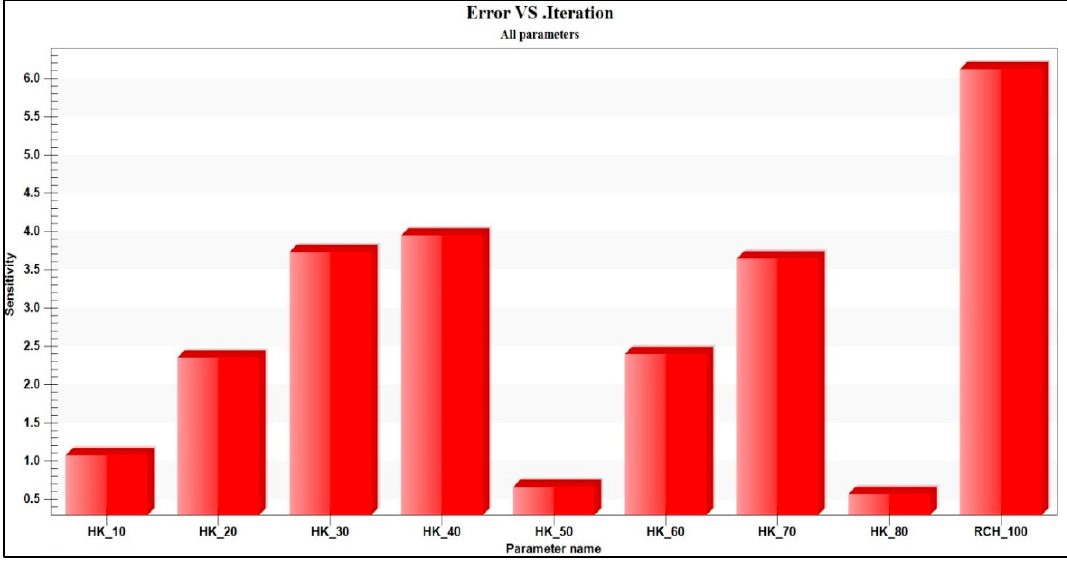
Figure 11. Model parameter sensitivity